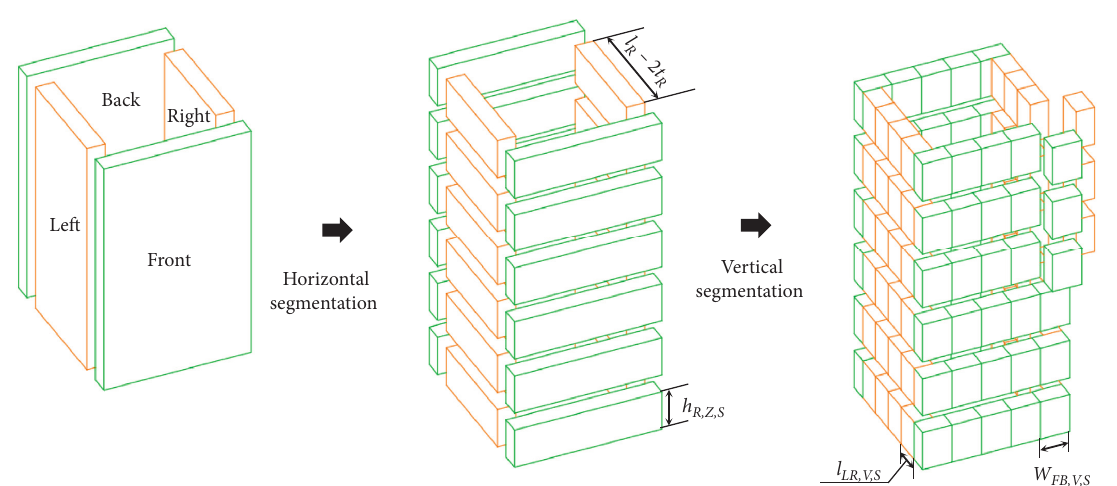
Figure 7: Schematic view of sequential segmentation strategy for the rectangular prism-type object shown in Figure 1(b).